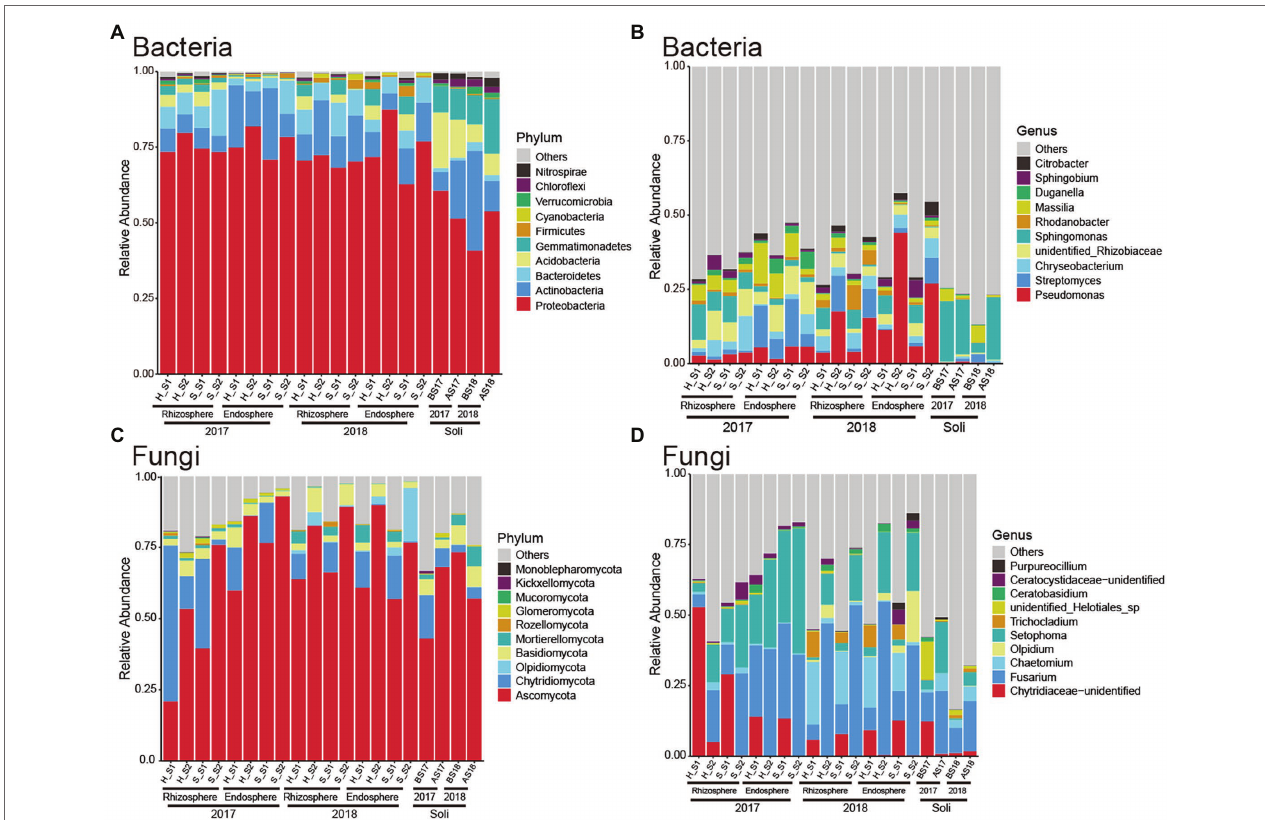
FIGURE 3 | Composition of microorganisms at the phylum and genus levels in RKN-infected and healthy tobacco at different times. (A) The relative contributions of the top 10 phyla of bacteria at the phylum level at different times in RKN-infected and healthy tobacco. (B) The relative contributions of the top 10 genera of bacteria. (C) The relative contributions of the top 10 fungi at the phylum level at different times. (D) The relative contributions of the top 10 genera of fungi at the genus level at different times in tobacco roots. S1: 0–45 days, S2: 45–90